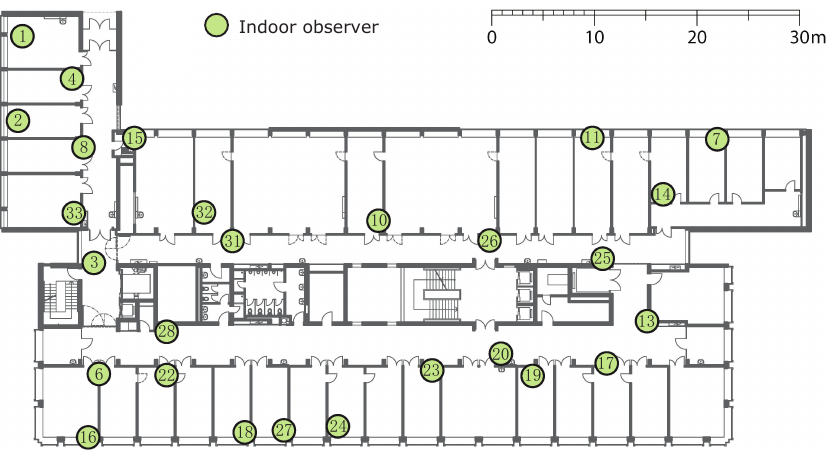
Figure 15. Deployment of sensor nodes in FlockLab.